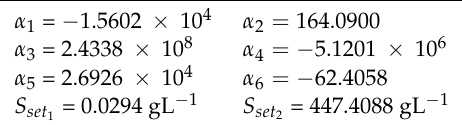
Table 2. α j values and S set solutions for µ set = 0.18 h − 1 and X set = 10 gL − 1